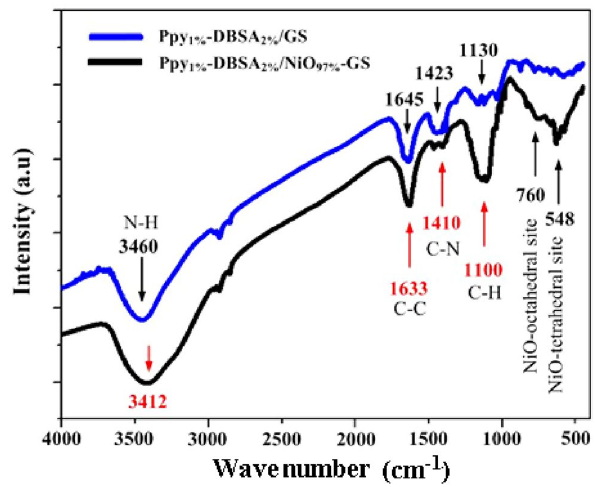
Figure 3. FTIR spectra of pure Ppy 1% -DBSA 2% /GS and Ppy 1% -DBSA 2% /NiO 97%